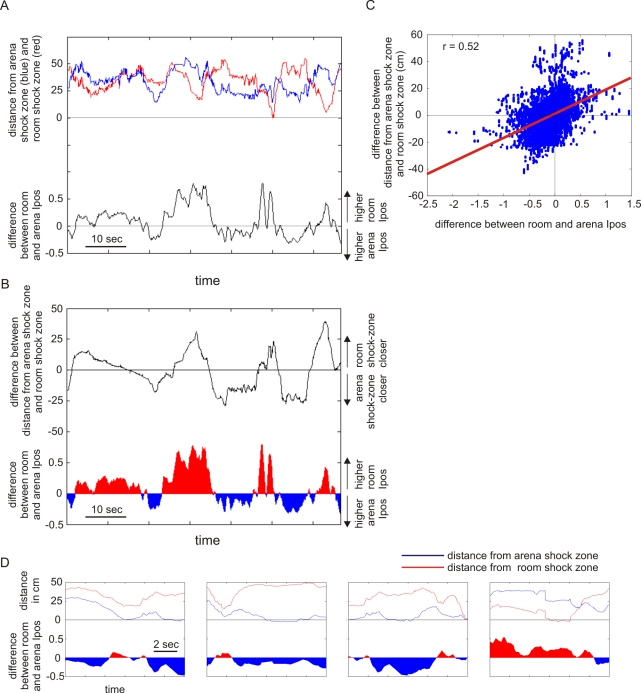
Ongoing frame-specific ensemble discharge is related to concurrent two-frame behavior.(A) The distances of the rat from the room (red) and arena (blue) shock zones and the difference between room and arena ensemble Ipos (black) are shown for 80 s. Ensemble activity better indicated locations in the same spatial frame as the nearby shock zone. (B) The difference between distances from the two shock zones (black line) and the difference between the ensemble Ipos in the two spatial frames covary. (C) This correspondence was observed during the entire session. (D) Ensemble activity during the 5 s before and after entering a shock zone (y-axis labels as in panel B). These examples from a session with the shock off illustrate that ensemble activity typically reflects the “riskier” frame that defined the nearby shock zone and that the rat did not go deep into a shock zone.